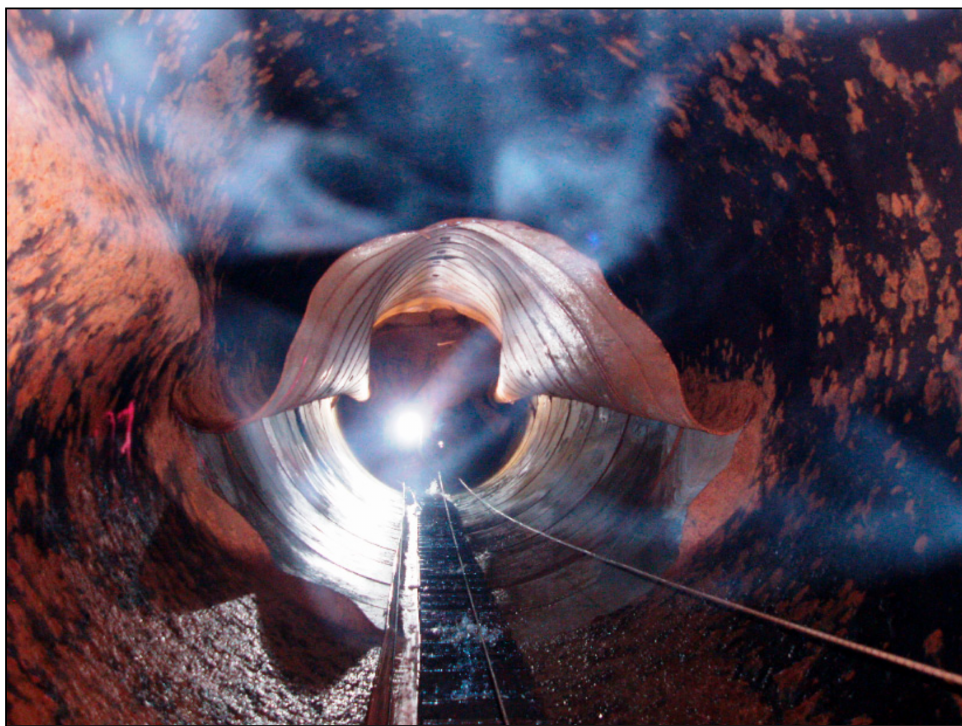
Figure 7. Liner failure as a consequence of external pressure. (Photo taken by the